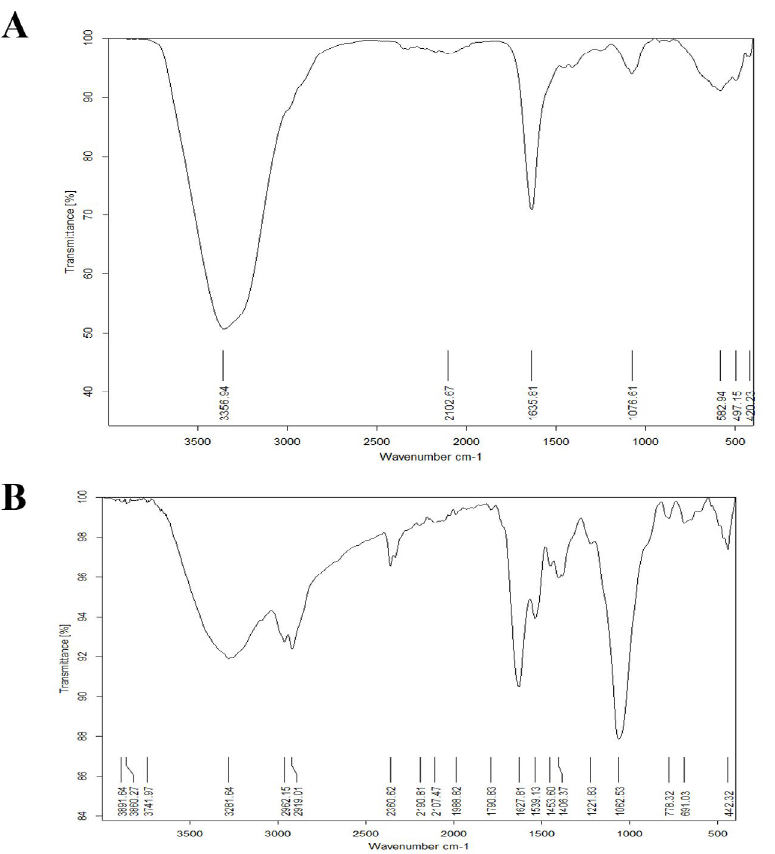
Fig. 12. (A ) FTIR spectra of Bacillus maritimus Culture and ( B ) : FTIR spectra of nano silver and Bacillus maritimus